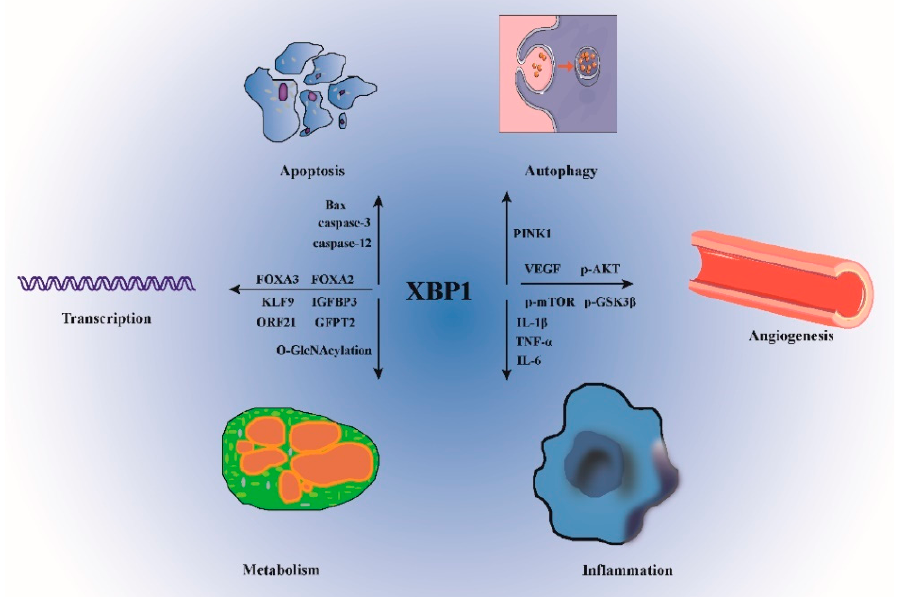
Figure 2. Research into the functions of XBP1s. XBP1s plays an important role in cardiovascular diseases by interacting with various signaling pathways. KLF9: Krüppel-like factor 9; FOXA3: Forkhead Box A3; IGFBP3: insulin-like growth factor binding protein-3; FOXA2: Forkhead Box A2; GFPT2: glutamine-fructose-6-phosphate transaminase 2.